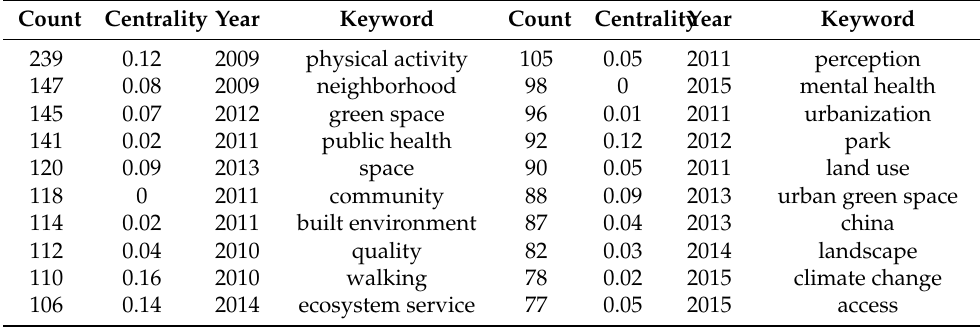
Table 8. Top 20 keywords based on